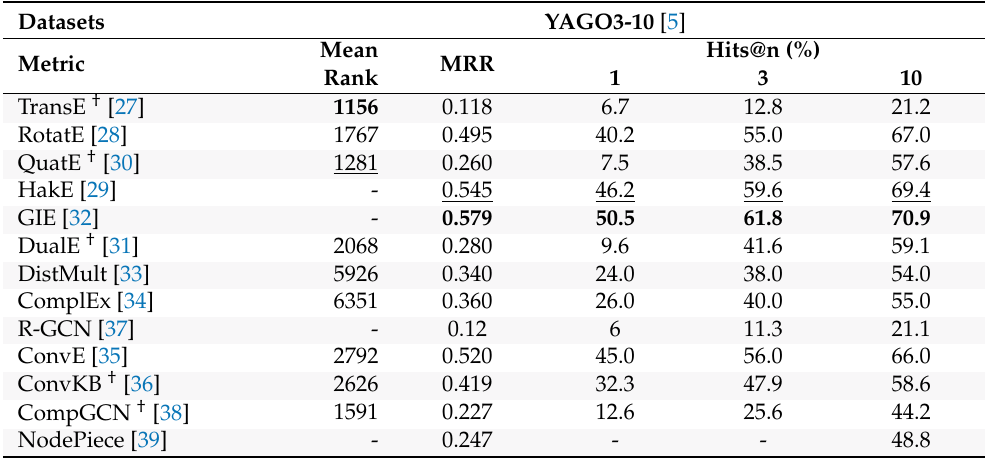
Table 7. Results on YAGO3-10; † refers to ours. Bold and underline denote the best and second best